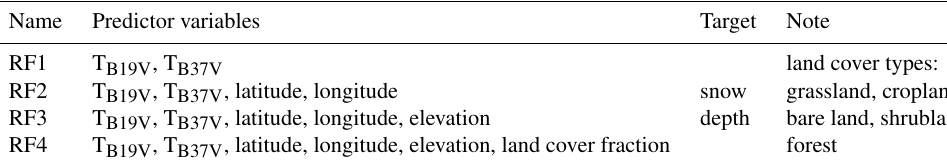
Table 2. A detailed description of the input predictor variables based on four selection rules of the training sample.